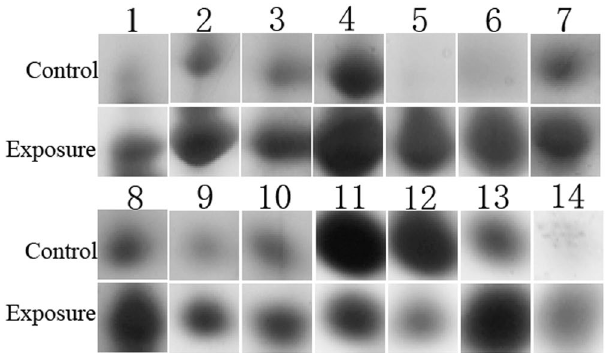
Figure 1. Differential analysis with zoomed images of a gel area from the N2 worms intoxicated by Cry6Aa2 toxin (Exposure) and from a comparable area of gel showing protein patterns from control worms unexposed to Cry6Aa2 toxin (Control).